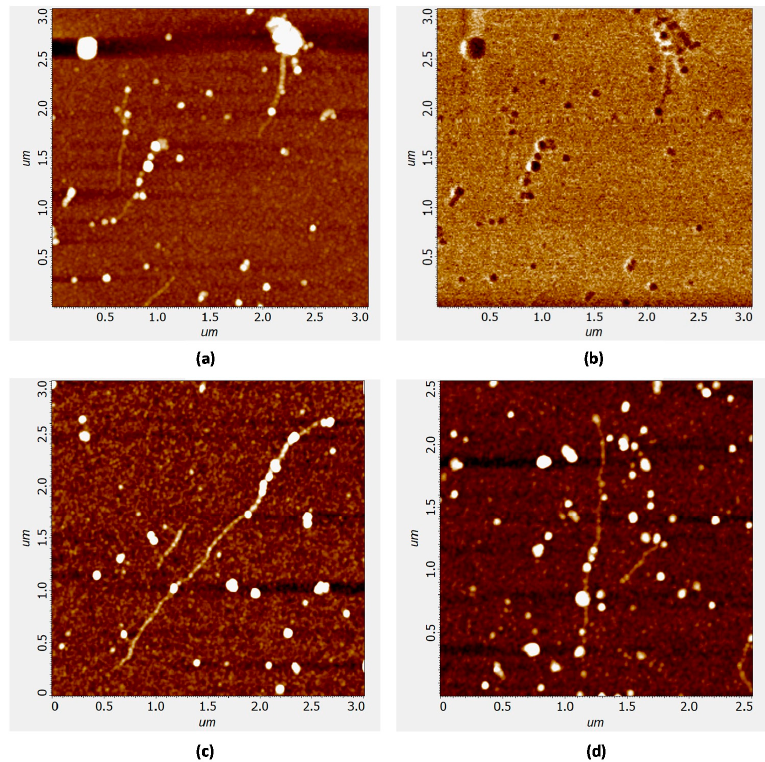
Figure 3. AFM image of Au NPs distribution with respect to phage filamentations ( a ), same image in phase contrast to enhance the Au NPs ( b ), and of single phages showing high number of nanoparticles adherent to them ( c , d ).